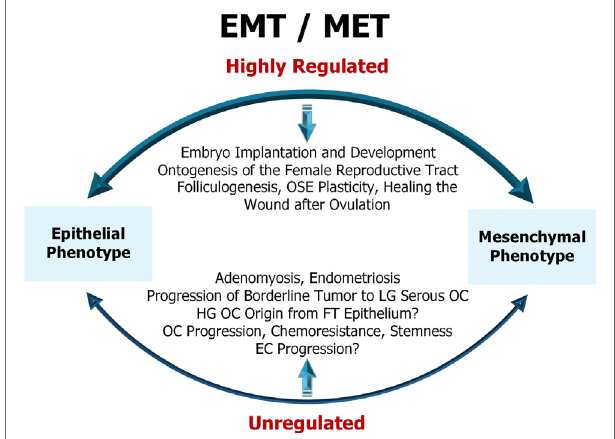
FigURe 1 | Representative diagram of epithelial-to-mesenchymal transition (EMT)/mesenchymal-to-epithelial transition (MET) in female reproductive tract. EMT/MET are highly regulated physiological processes in embryo implantation and early development as well as in the reproductive function of the ovary and endometrium. Dysfunction of EMT in the normal epithelial cells of the ovary and uterus results in pathological processes, such as adenomyosis, endometriosis, cancer initiation, progression, and resistance to therapy. OSE, ovarian surface epithelium; LG serous OC, low-grade serous ovarian cancer; HG OC, high-grade ovarian cancer; FT epithelium, fallopian tube epithelium; EC, endometrial cancer. For a detailed description of the diagram and references refer to Sections “Physiological (Non-Malignant) EMT in the Female Reproductive Tract” and “EMT in Cancers of the Female Reproductive